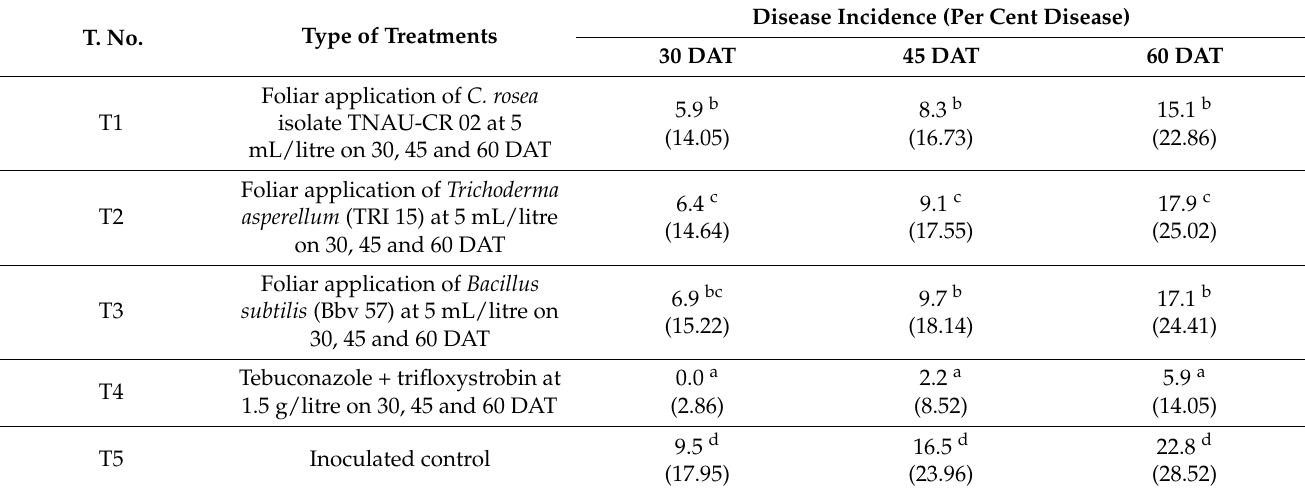
Table 3. Efficacy of biocontrol agents on the severity of cabbage head rot pathogens under green- house